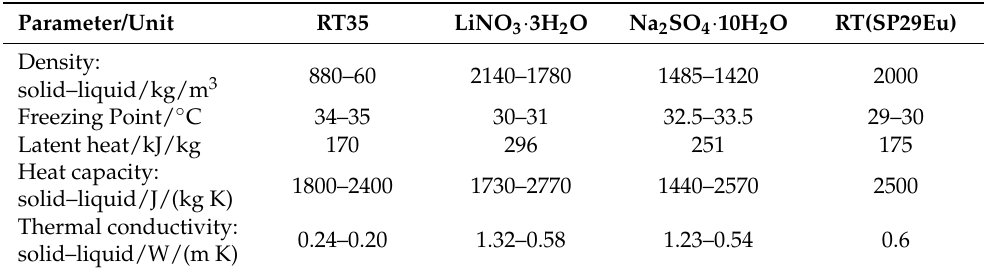
Table 2. The thermophysical properties of selected phase change materials